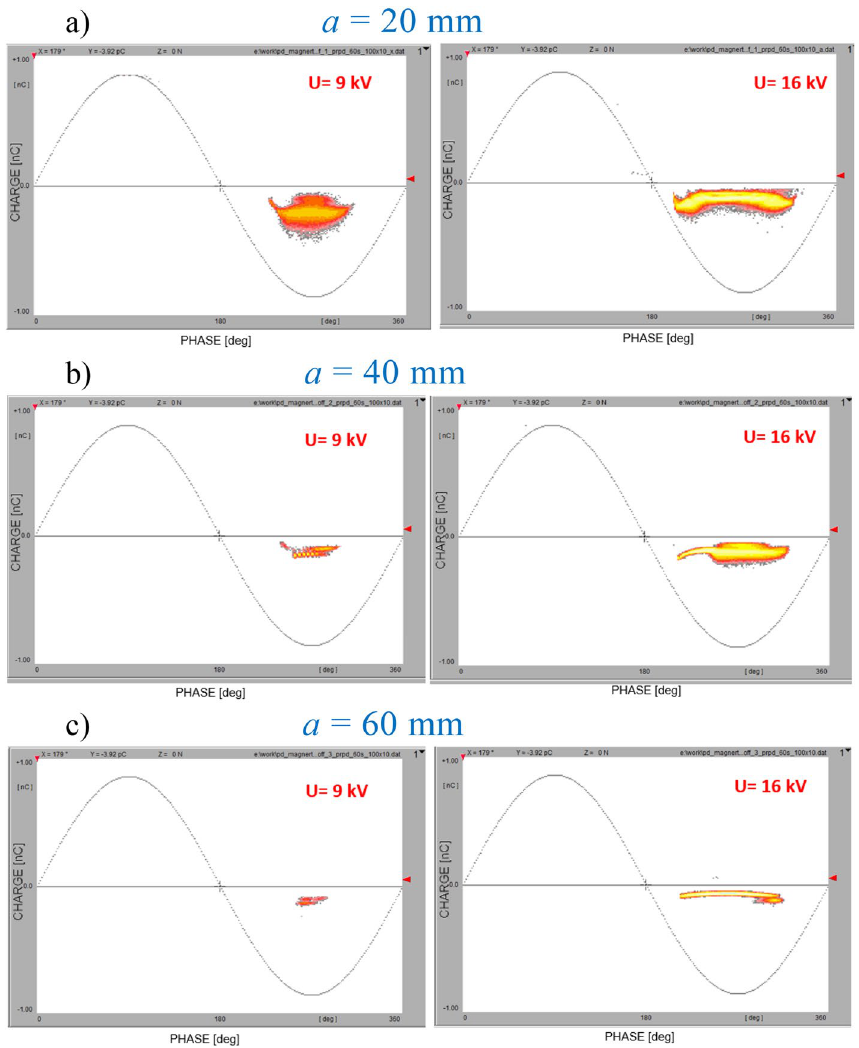
Figure 12. PD patterns recorded (B = on) for two extreme voltage values (9 kV—left column, and 16 kV—right column) and for three interelectrode distances: ( a ) a = 20 mm, ( b ) a = 40 mm, ( c ) a = 60 mm.